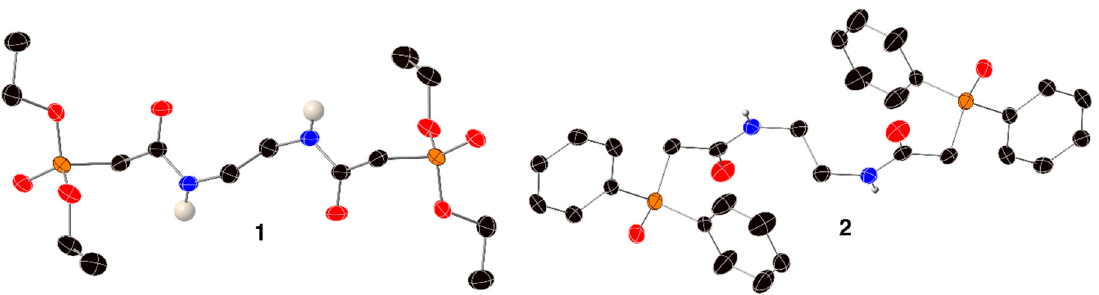
Figure 2. X-ray crystal structures of organic ligands 1 [25] and 2 . Thermal ellipsoids are depicted at the 50% probability level using standard CPK colors, and all hydrogen atoms bonded to carbon atoms have been omitted for clarity. Only the major component of compound 2 is shown here; details regarding the treatment of this disorder are given in the Supplementary Materials. Table 2. Crystal data and structure refinement for free ligand 2 , and the metal complexes